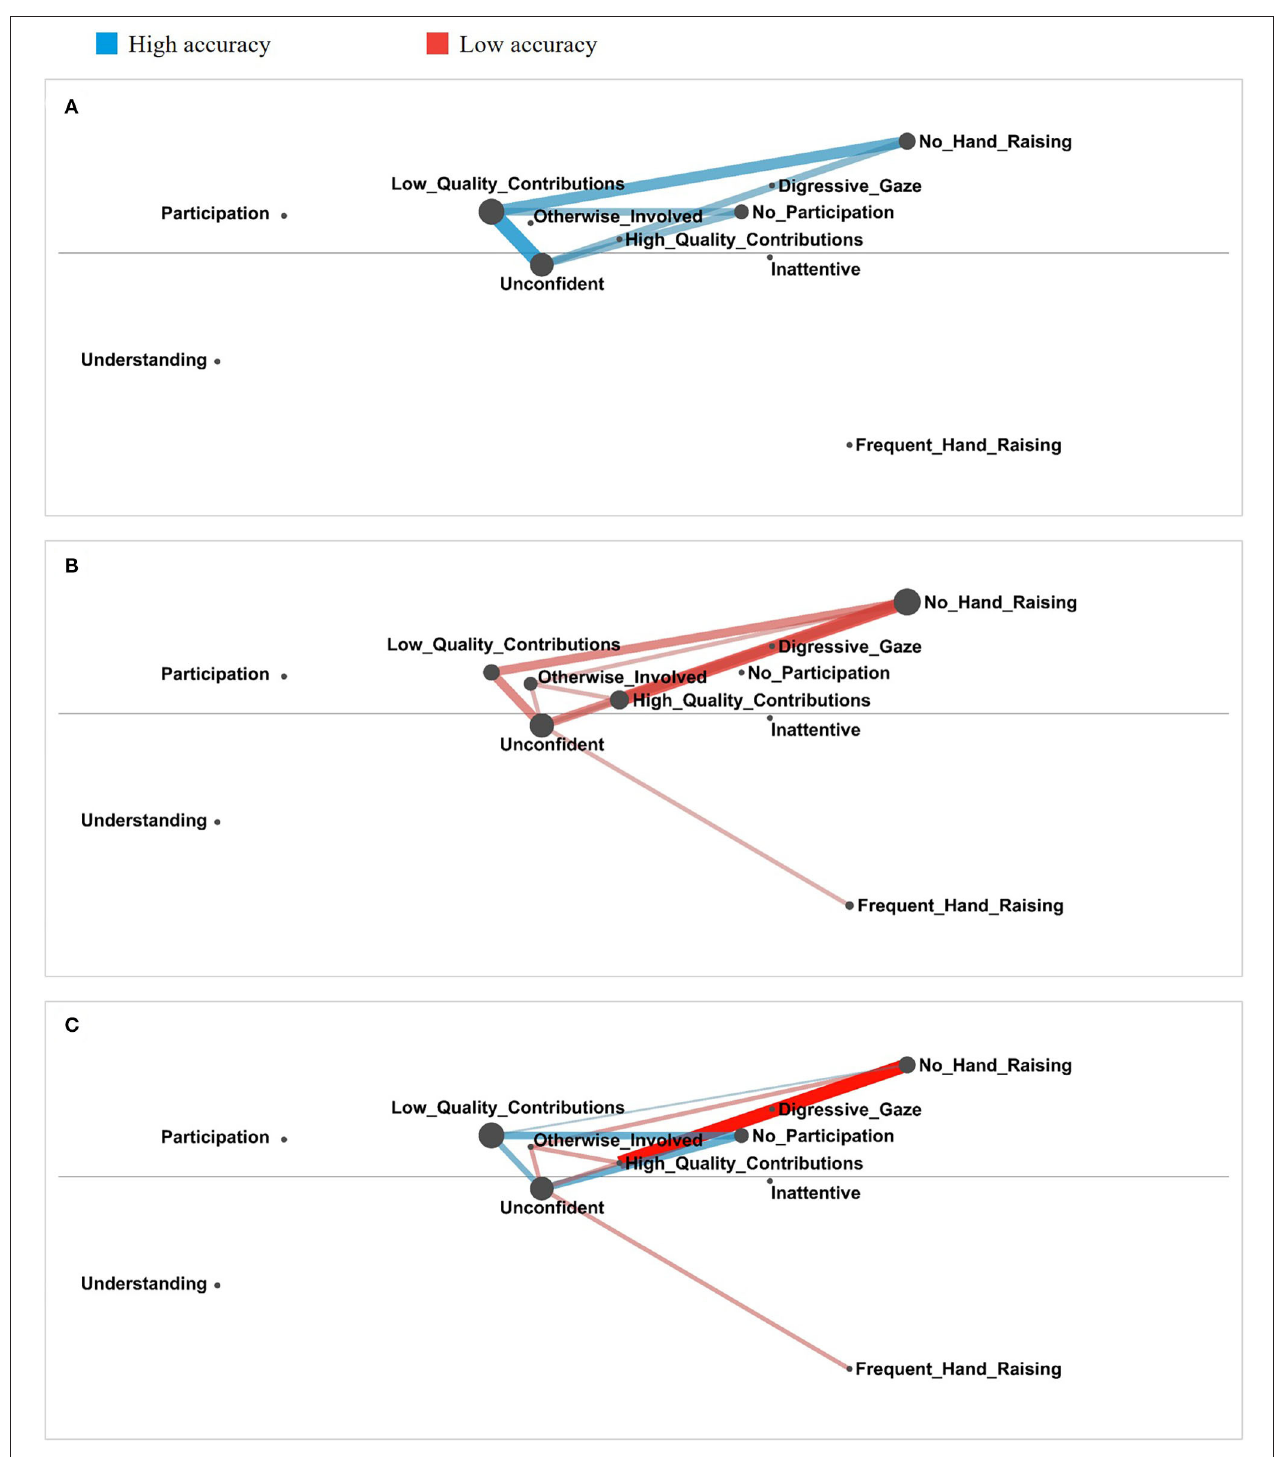
FIGURE 8 | Comparison of networks for struggling student profile between student teachers with high and low judgment accuracy. (A) Depicts the network of the struggling student profile for student teachers with high accuracy. (B) Depicts the network of the struggling student profile for student teachers with low accuracy. (C) Shows the comparison of both networks. Here, the color of connections indicates which group utilized the respective code combination more frequently. In order to make the characteristics of the individual networks clearly visible and to make the differences visually easier to recognize, minimum edge weight and scale for edge weight were set to 0.1 and 1.3,